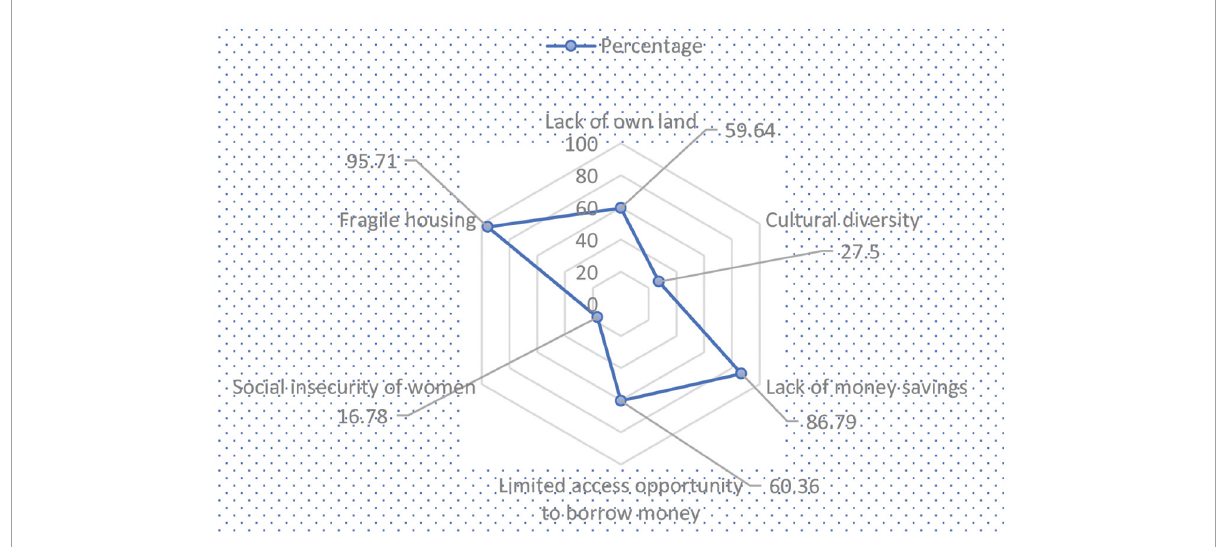
FIGURE5 Radar chart on components of adaptation obstacles to livelihood